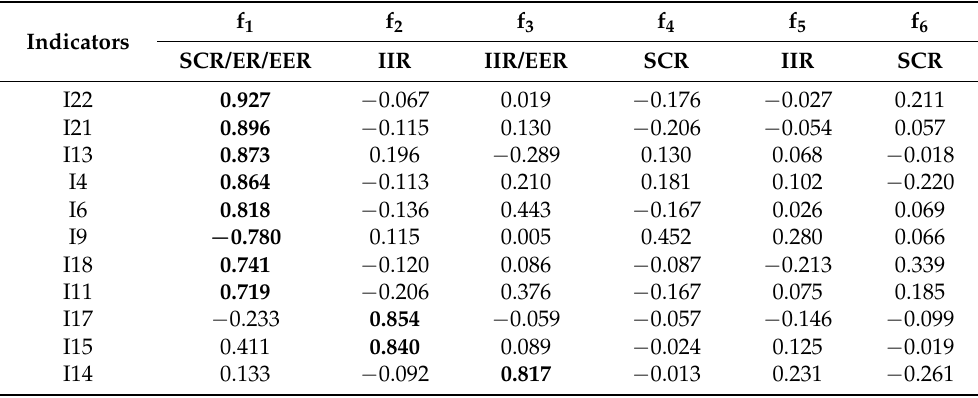
Table 4. Rotated component